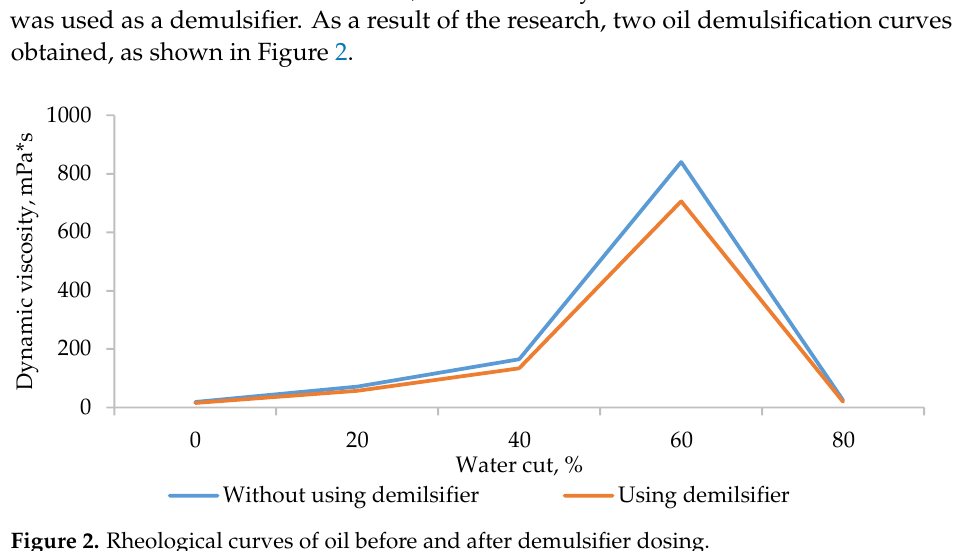
Figure 2. Rheological curves of oil before and after demulsifier dosing.